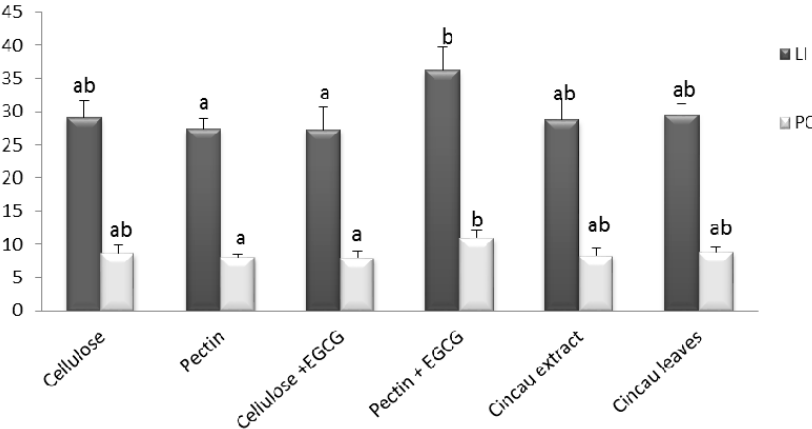
Figure 2. Effects of different fibre diets on proliferating cell nuclear antigen (PCNA) labelling index (dark bars) and the number of PCNA positive cells (light bars) in the mucosa of distal colon of rats six weeks after the second injection with the carcinogen azoxymethane (AOM) (2 × 15 mg/kg). Values are the mean ± SE ( n = 12). Means with a different letters on the bar are statistically significantly different ( p ≤ 0.05). EGCG, 0.1% epigallocatechin ‐ 3 ‐ gallate. LI, the PCNA labelling index (%); PC, the number of PCNA positive cells.